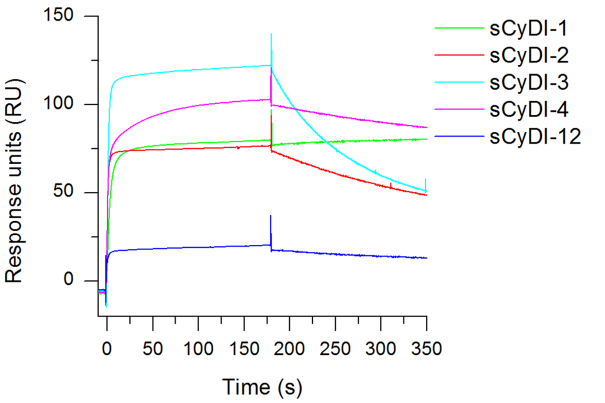
Fig 2. SPR analysis of antibodies from hybridoma supernatants based on their ability to bind and release hCC. Antibodies from monoclonal hybridoma supernatants were analysed according to their hCC binding (180 s) and dissociation characteristics. The supernatant was pre-diluted 1:6 in PBS. The responses resulting from the capture of hCC by five antibodies are shown in different colours. The antibodies originated from three different hybridoma generations and their capture level differed according to their abundance in the